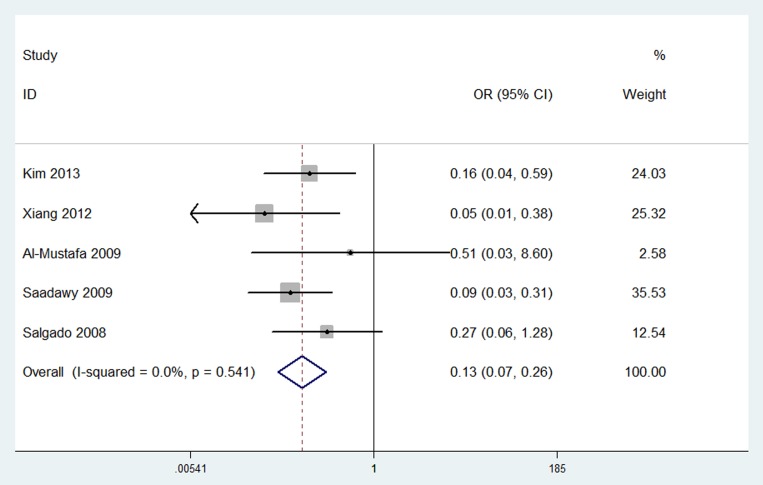
Forest plot: The number of postoperative analgesic requirements.